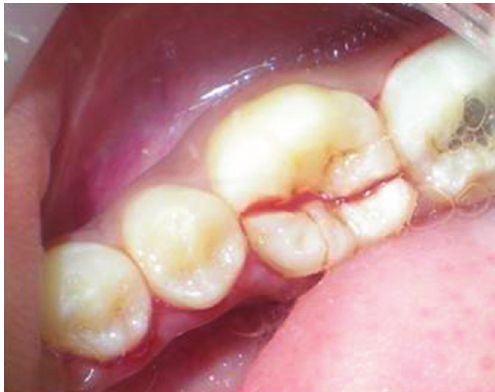
Figure 7: Preoperative periapical radiograph with 36 showing the radiolucent fracture line in the coronal area and passing through the pulp chamber.